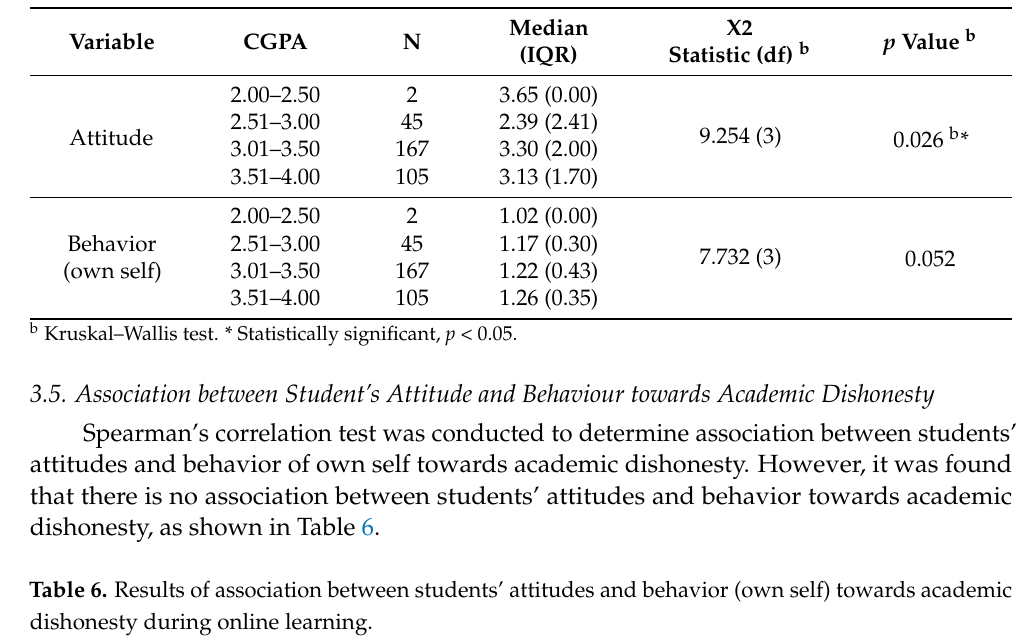
Table 5. Results for students’ attitudes and behavior towards academic dishonesty during online learning in association with CGPA.